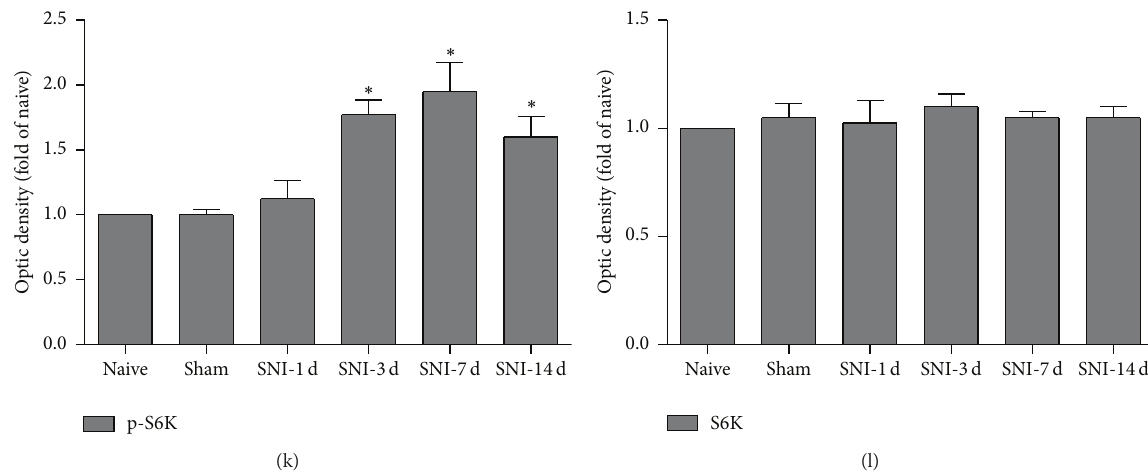
Figure 2: mTOR was remarkably activated in the RVM after SNI. (a)–(f) Double immunostaining showed that p-mTOR (red) was almost exclusively expressed in neurons (green). Single arrows indicate some typical double-labeled (yellow) cells. (a)–(g) Cell counting in the RVM shows that the number of p-mTOR-positive neurons was significantly increased 7 days after the SNI surgery ( ∗ 𝑃 < 0.05 compared to the sham control group). Scale bars = 100 𝜇 m. (h)–(l) The expression levels of total and phosphorylated mTOR (h, i, and j) and S6K (h, k, and l) were revealed by western blotting. Three days after SNI, phosphorylated mTOR and S6K (p-mTOR and p-S6K) in the RVM were significantly increased. Nonphosphorylated mTOR and S6K were not changed after SNI ( ∗ 𝑃 < 0.05 compared to the na¨ıve control group, 𝑛 = 4 ).